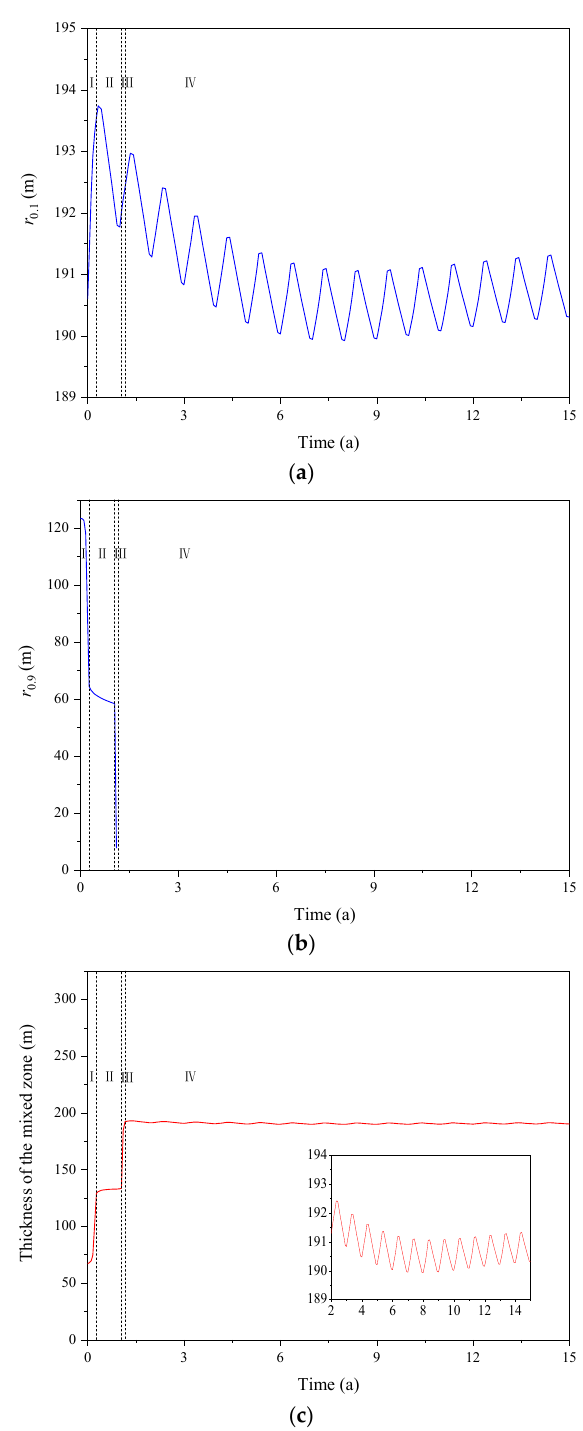
Figure 9. ( a ) The distance between the CO 2 injection well and the point with 10% CO 2 in the diagonal section of the reservoir during production; ( b ) the distance between the CO 2 injection well and the point with 90% CO 2 in the diagonal line of the reservoir; and ( c ) the thickness of the mixed zone during production.